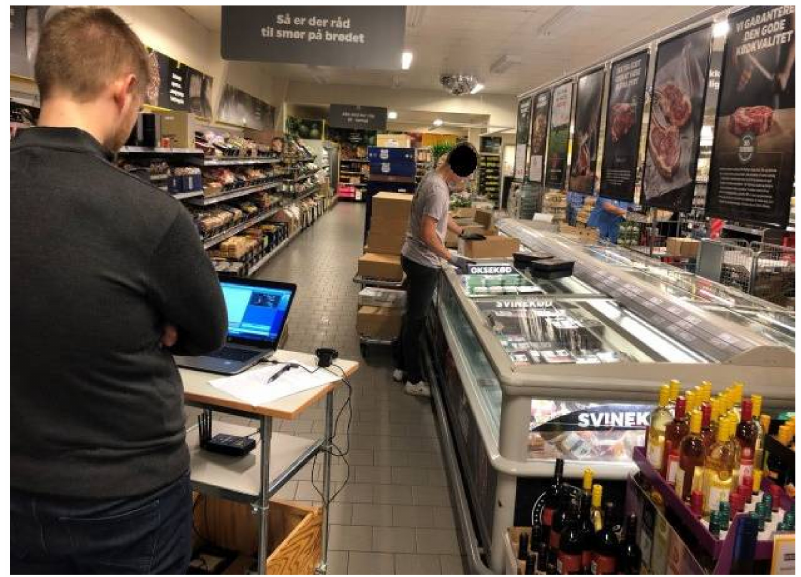
Figure 1. Measurements of muscular workload using sEMG and synchronous video